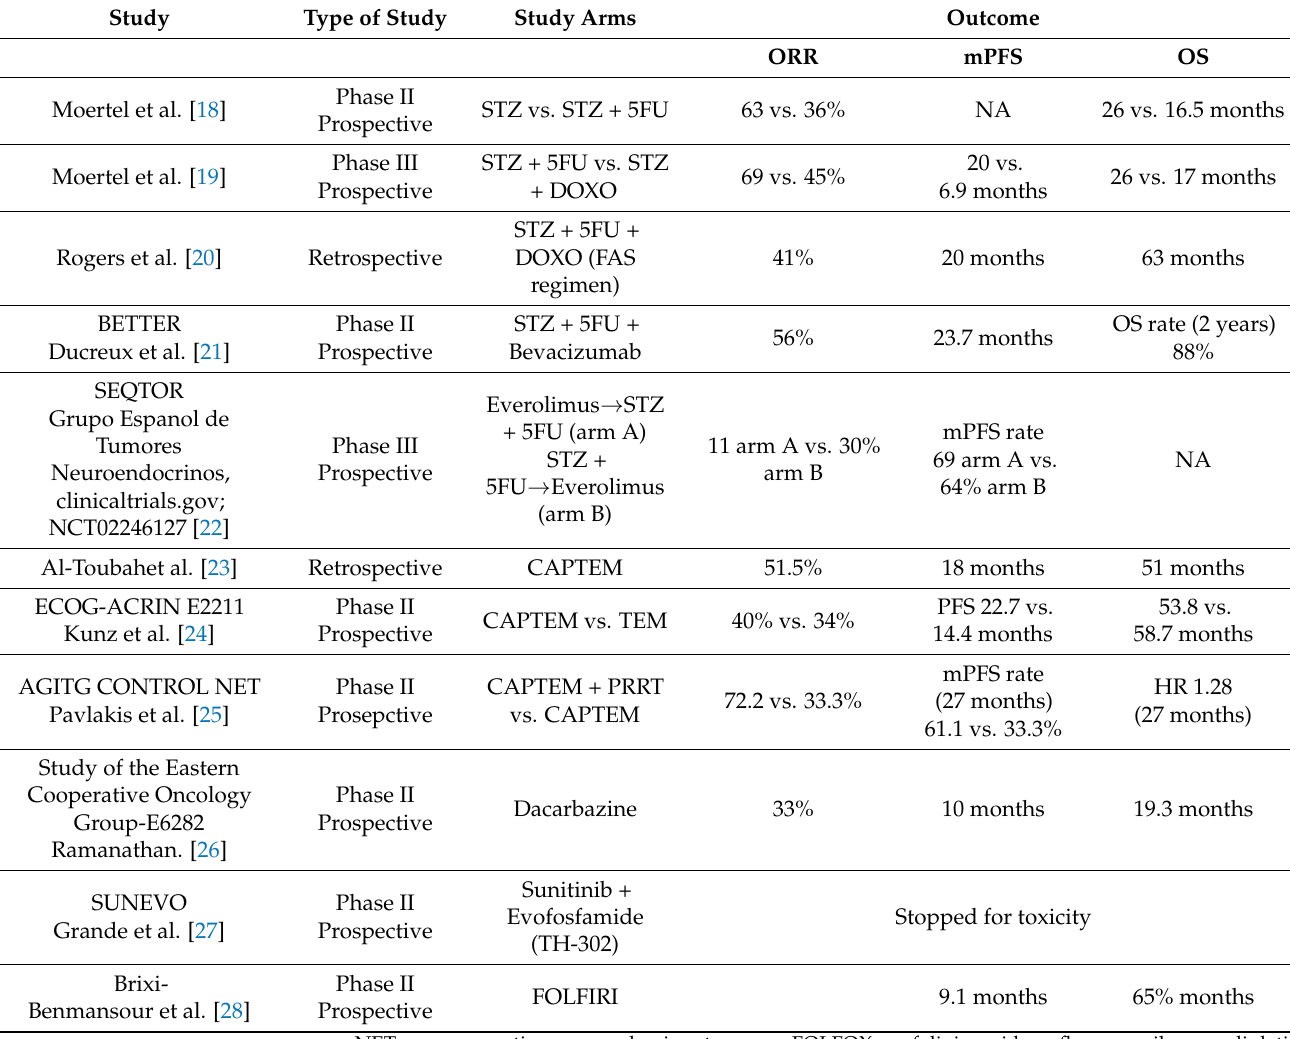
Table 1. Studies and trials of chemotherapy in G1-G2